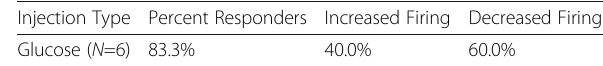
Table 3 Population results of the detected responders on glucose injection experiments. Glucose injections also elicited a response 83.3% of the time and tended to cause a decreased rate of firing